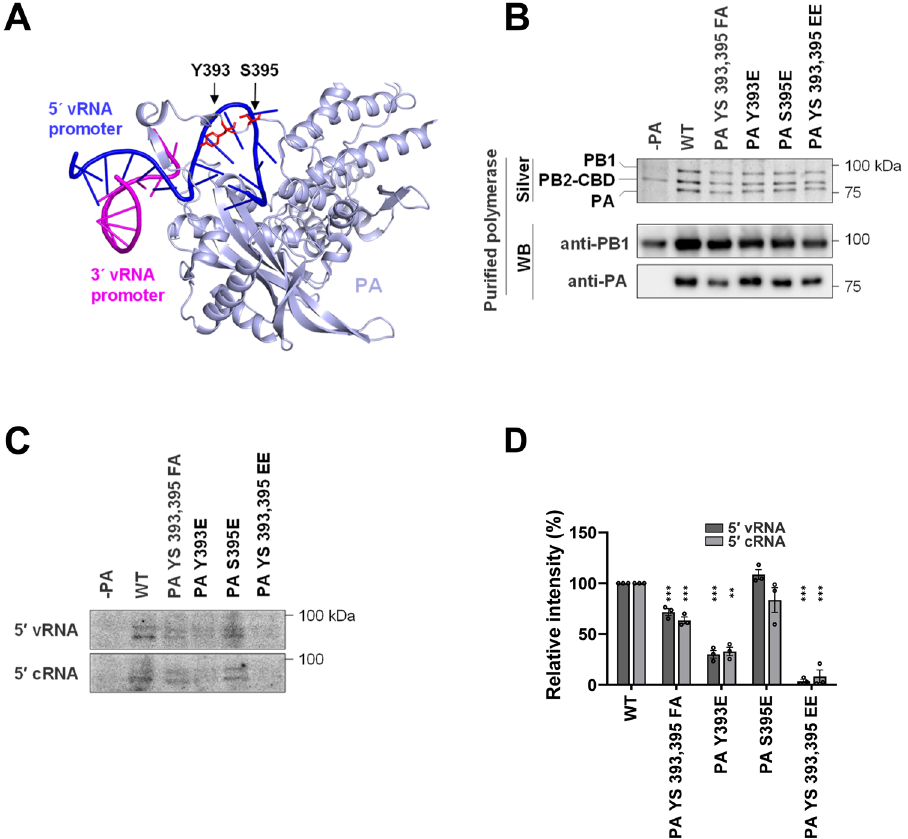
Figure 4. PA Y393 phosphorylation prevents polymerase binding to the 5 ′ -termini of vRNA and cRNA. ( A ) For convenient visibility only the PA subunit and the positions of Y393 and S395 phosphorylation sites are shown, the 5 ′ end of the vRNA forming a stem-loop is displayed in blue. The structures were displayed using Pymol (PDB: 4WSB). ( B ) The trimeric polymerase complex was expressed in 239T cells and purified using the TAP tag. The purified material was analyzed for purity and integrity of the polymerase subunits by silver staining (upper) and immunoblotting (lower) as shown. ( C ) The purified polymerase was incubated with the radiolabeled 5 ′ ends of vRNA or cRNA in the presence of their respective unlabeled 3 ′ promoters. After UV crosslinking the RNA/polymerase complex, the proteins were resolved by SDS-PAGE and the dried gel was analyzed by phosphorimaging. ( D ) Quantitative analysis of three different RNA-binding experiments, each performed with a different preparation of purified IAV polymerase. After subtraction of background obtained in the control lacking the PA protein the data were normalized to the silver-stained input control, the intensity of the WT polymerase was set to 100%. Data are mean ± SEM (** P ≤ 0.01 and *** P ≤